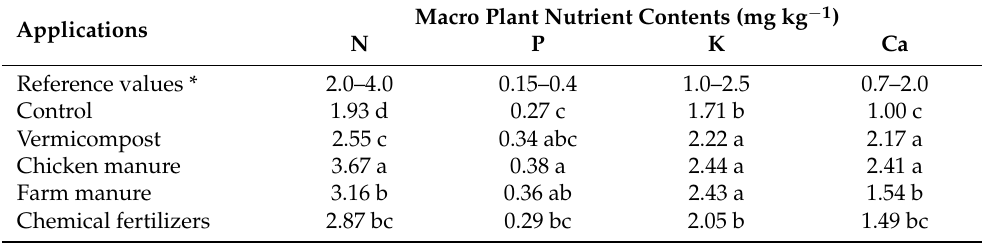
Table 7. Effects of fertilizer applications on the macro plant nutrient content as determined from the leaves.